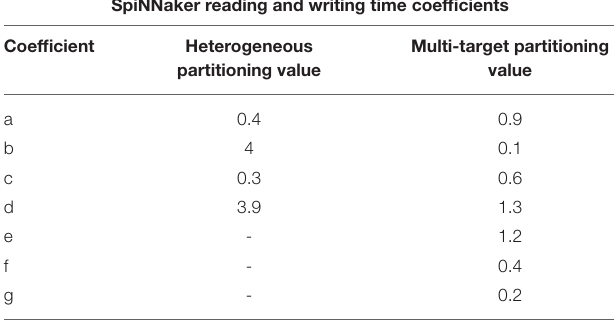
TABLE 1 | Reading and writing time coefficients for the Heterogeneous and Multi-target partitioning measured on